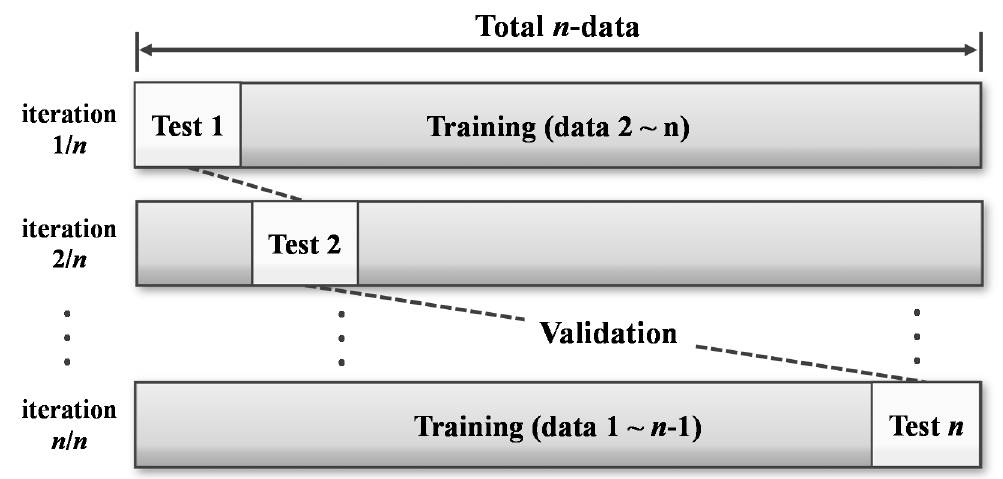
Figure 4. Leave-one-out cross-validation.